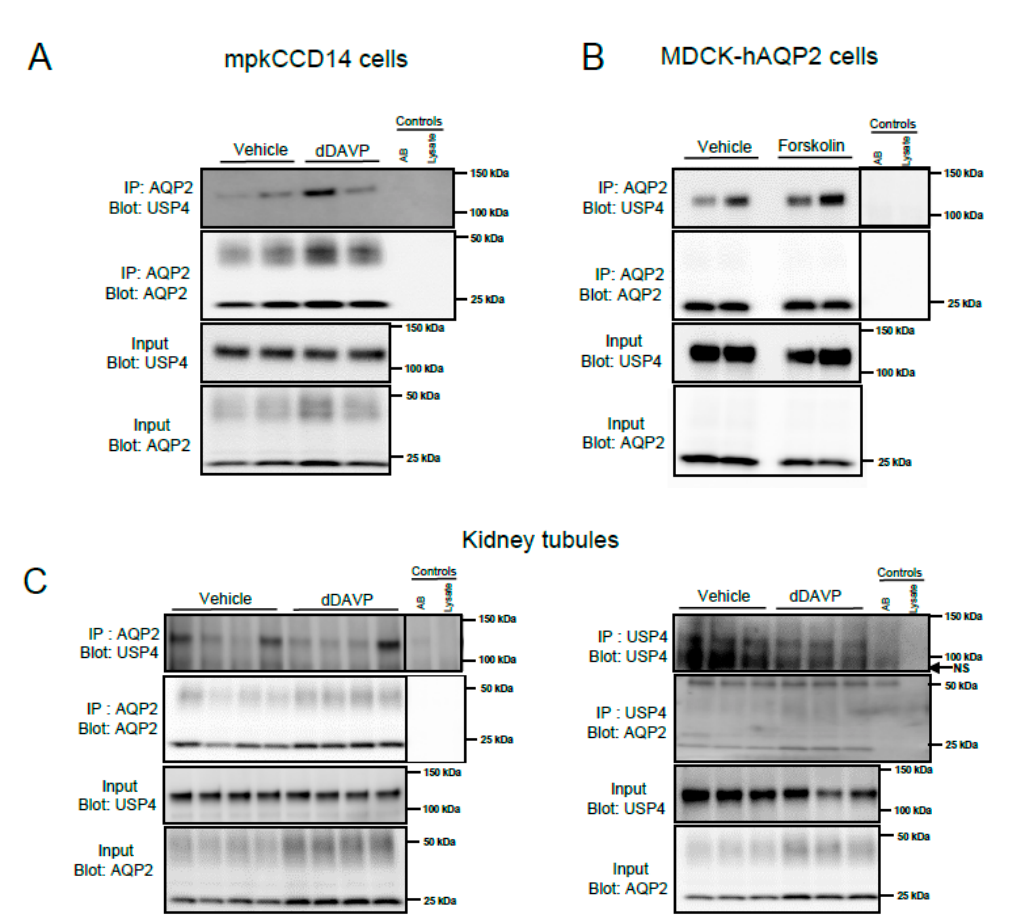
Figure 2. AQP2 and USP4 interact in vitro and in vivo. For studies in cultured mpkCCD14 cells,